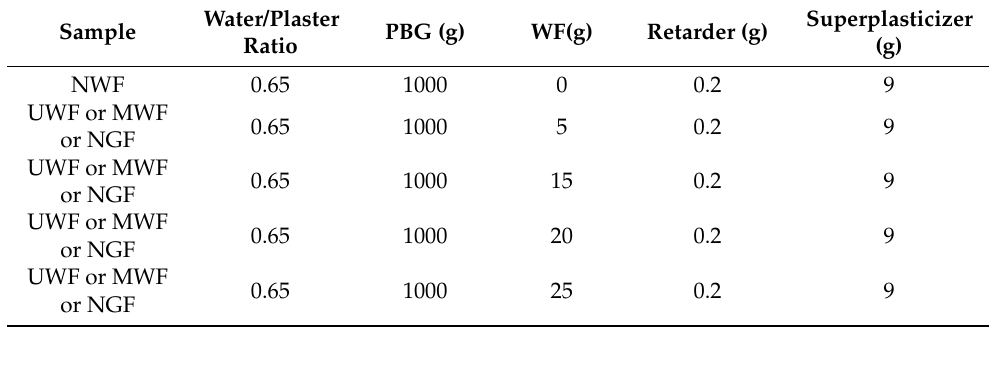
Table 2. Mix proportions of PBGC samples.